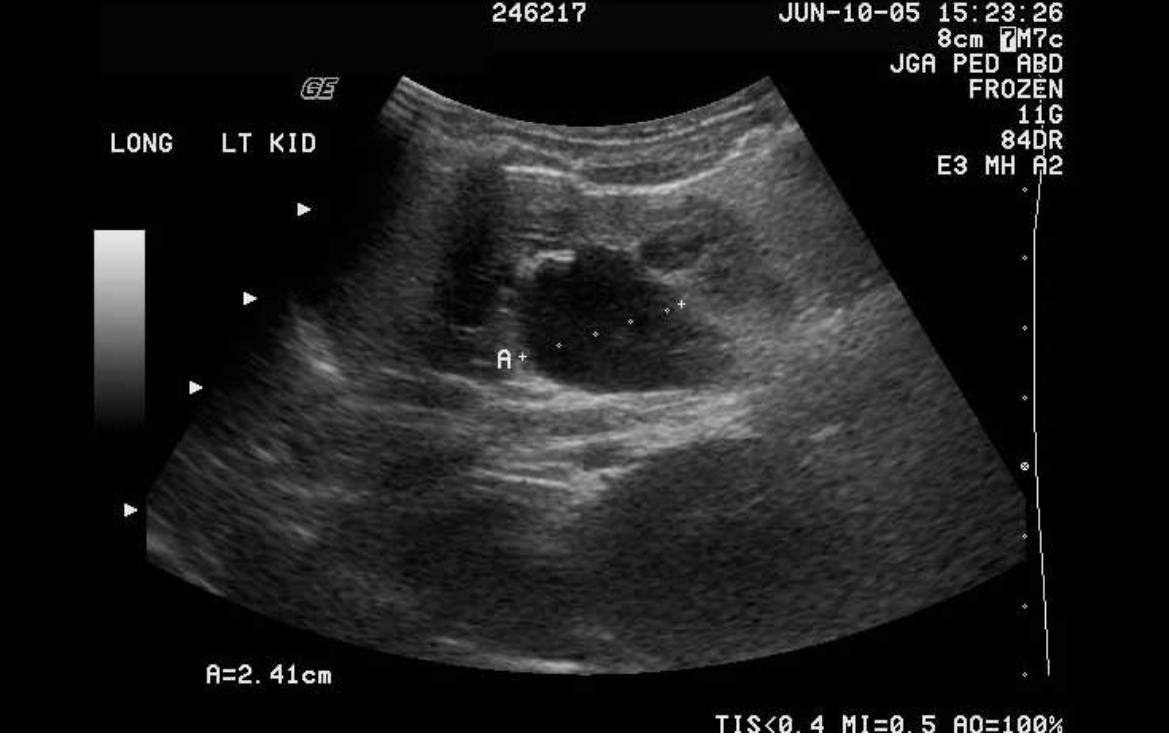
FIGURE 4C. Ultrasound demonstrating renal pelvis distention outside of renal border, calyceal distention without parenchymal thinning (SFU grade